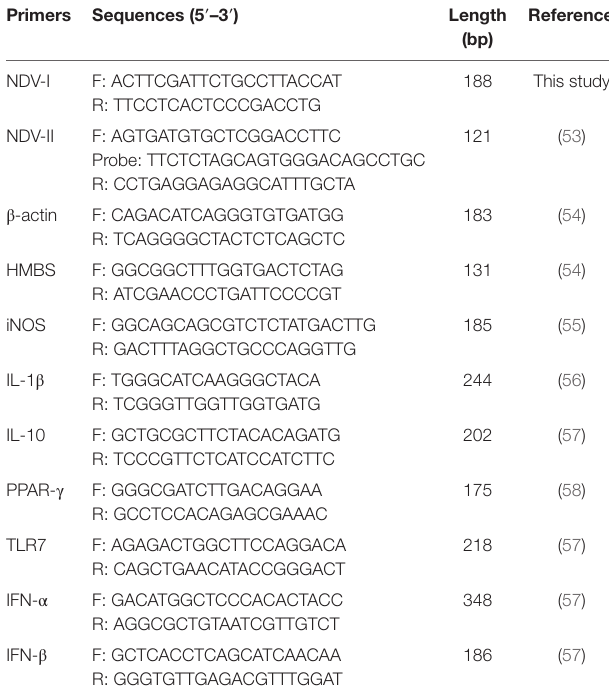
Table 1 | Primers and probe of qPCR were used in the work. Primers sequences (5 ′ –3 ′